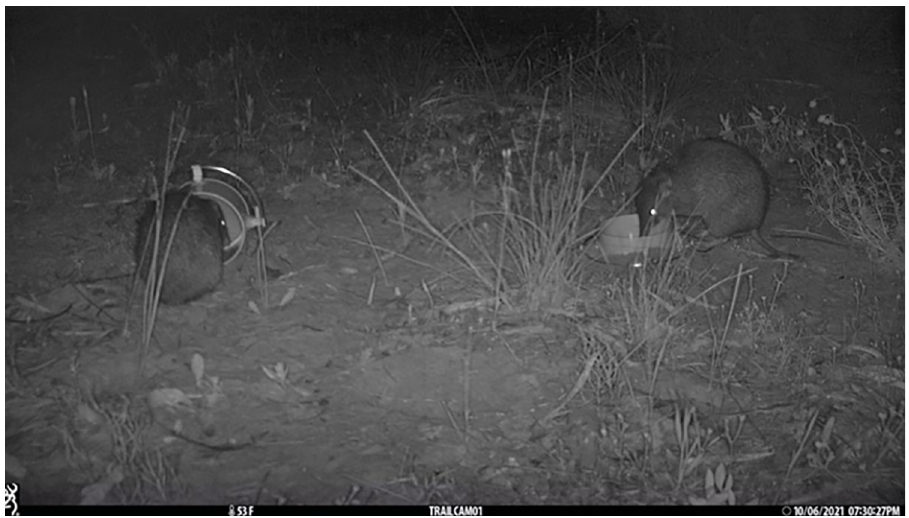
Fig 3. Quenda entering feeding stations (PVC pipes) through an RFID logger antenna allowing them to be uniquely